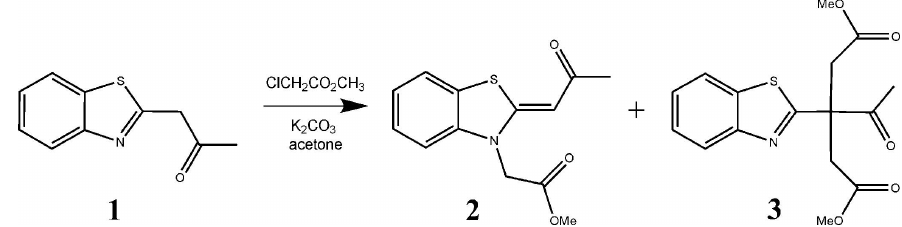
The formation of the title